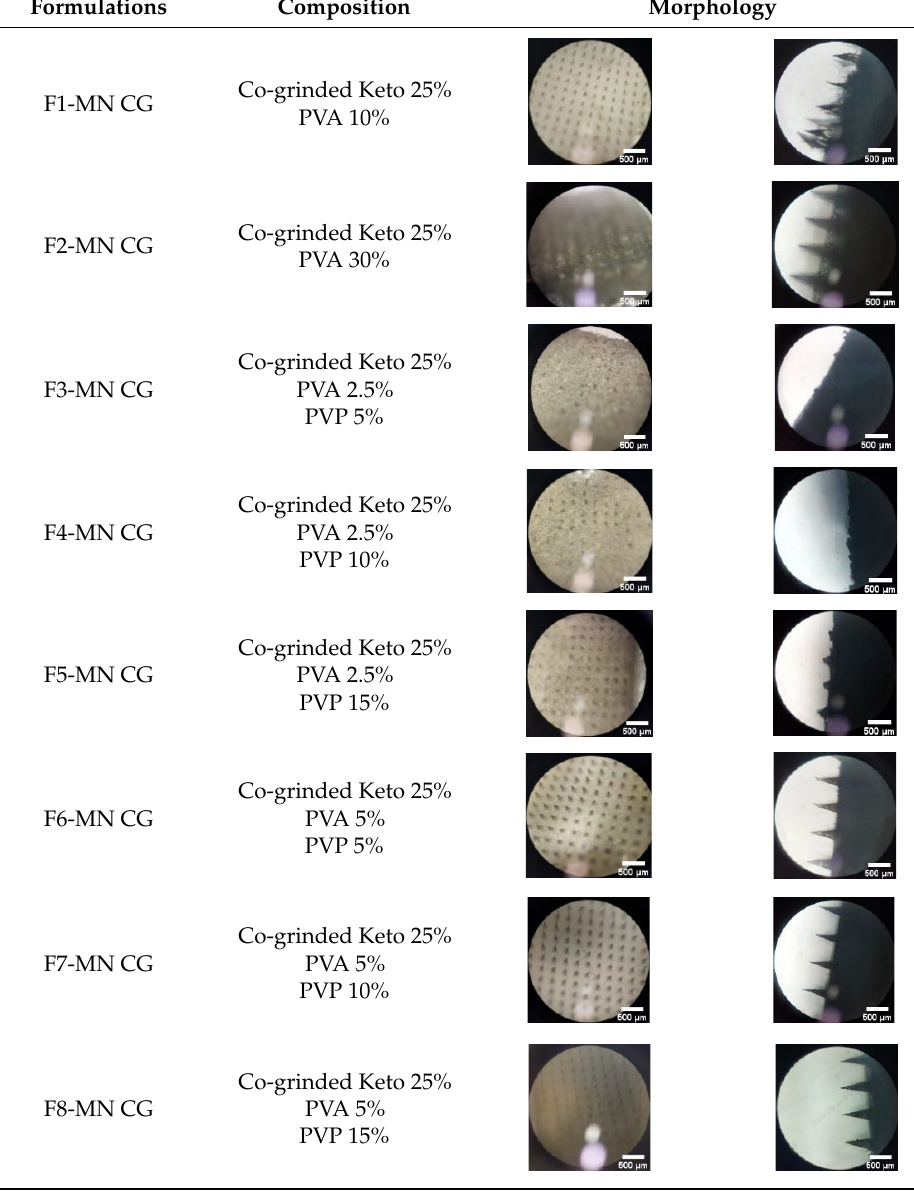
Table 5. Observation Results of Dissolving Microneedle Loaded with Co-grinded Ketoprofen Through a Microscope (scale bar: 500 µm). (PVA: polyvinyl alcohol; PVP: polyvinyl pyrrolidone; Keto: Ketoprofen).